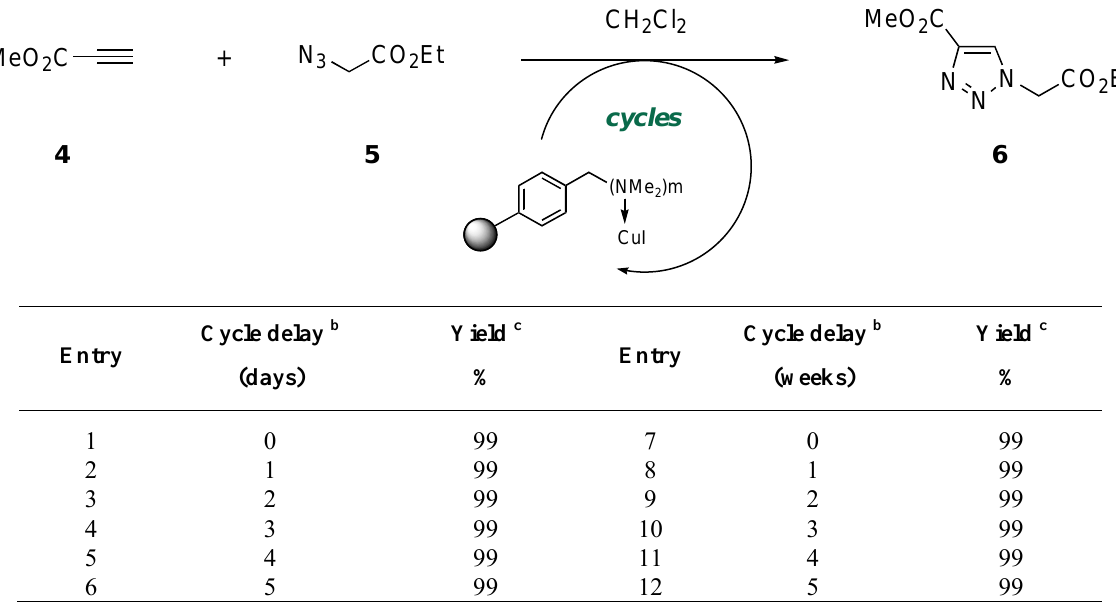
Table 1. Recycling A-21•CuI in the synthesis of the triazole 6 starting from 4 and 5 . a + MeO 2 C N 3 CO 2 Et 4 5 6